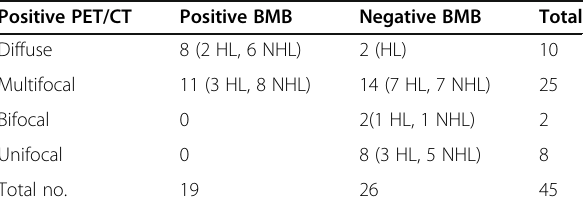
Table 5 Patterns of uptake in positive PET/CT results Positive PET/CT